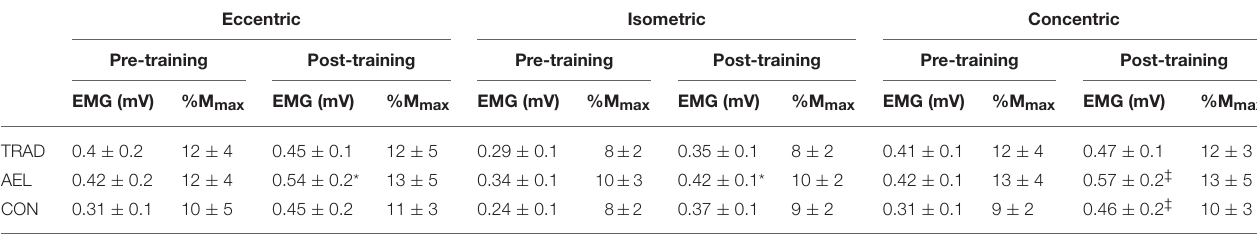
TABLE 1 | Mean ( ± SD ) absolute and normalized quadriceps muscle activity (EMG VL + VM + RF/3) during maximum eccentric, isometric, and concentric actions.